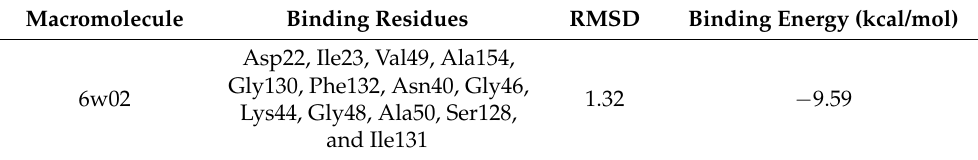
Table 2. Docking outcome of ADP ribose against ARP enzyme.